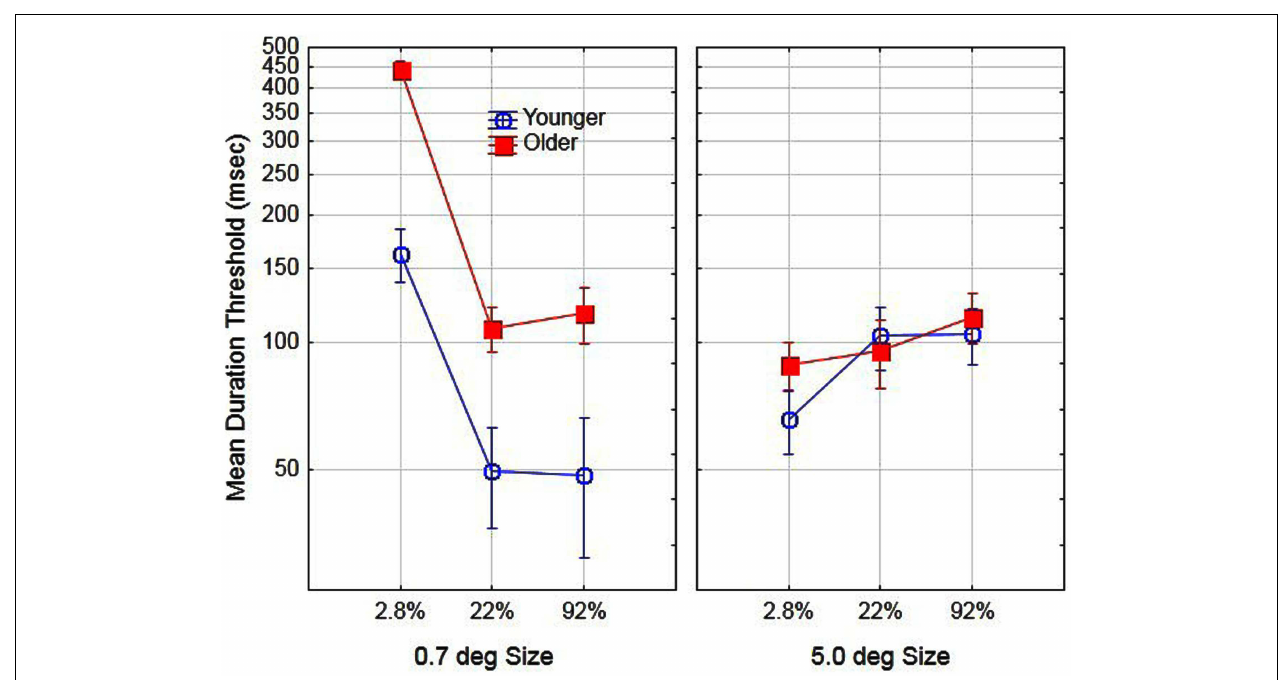
FIGURE 1 | Effects of stimulus size, contrast, and age on motion duration thresholds prior to training. Error bars represent ± 1 SE.